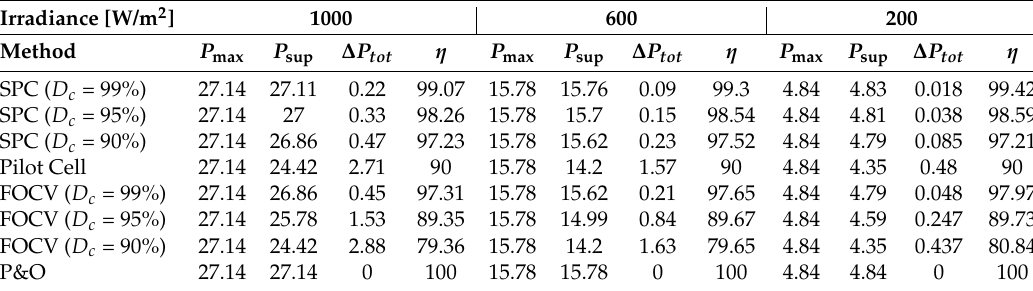
Table 5. Comparison between the proposed SPC-FOCV, conventional FOCV, and the pilot cell-based FOCV methods.